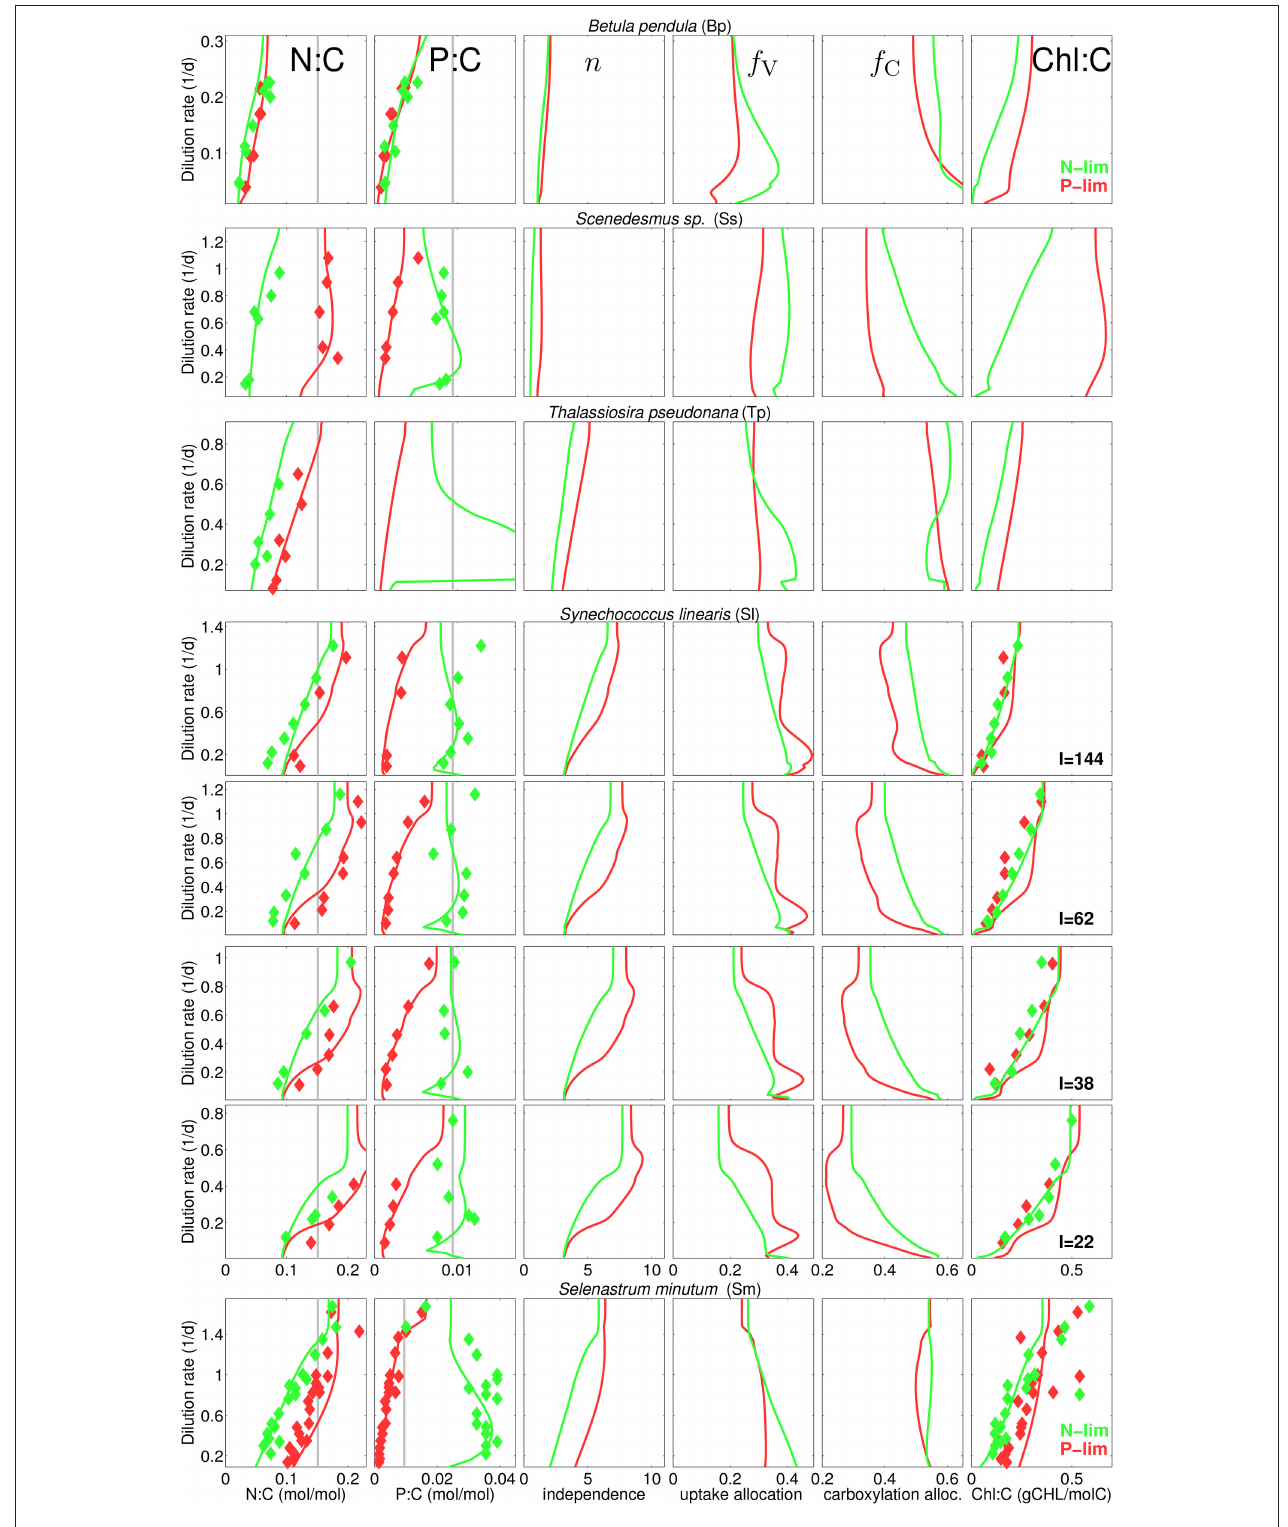
FIGURE 3 | Steady-state N:C, P:C, network independence n , and protein fraction for nutrient uptake ( f V ) and for carboxylation ( f C ), and chlorophyll-to-carbon ratio at different dilution rates for different experiments and culture species (see Table 1). Diamonds, reported data; Gray lines, Redfield stoichimetry; Lines, model for P-limited (red) and N-limited cultures (green).